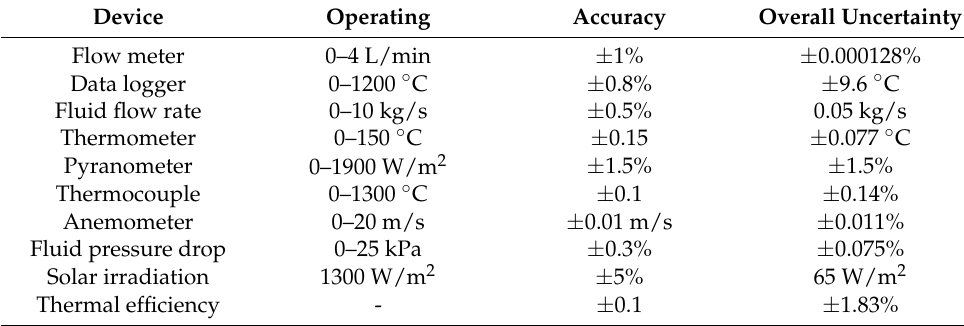
Table 3. Technical properties, accuracy, and overall uncertainty of the tools.